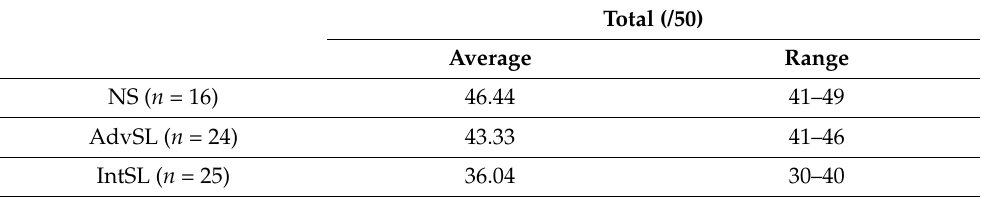
Table 3. Average and range proficiency scores for